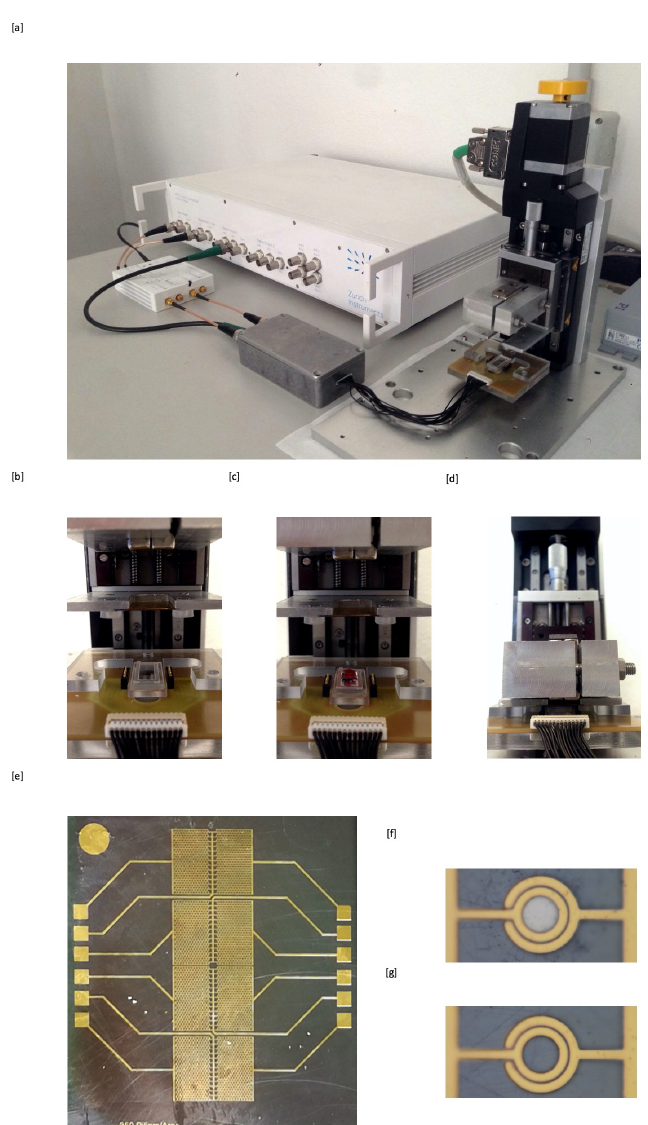
Figure 1. ( a ) Picture of the measurement set-up. A transimpedance amplifier (HF2TA) is used to convert the current flowing into the electrodes, upon application of a sinusoidal voltage with 100 mV amplitude at 1 MHz, in a voltage signal fed to a lock-in amplifier (HF2LI), both provided by Zurich Instrument. In this protoype, a first stepper motor (L40620SD00 from PhI) is used for the chip lowering, while a second stepper motor (M126 CG1 from PhI), mounted on the first, implements the magnet approach/disengagement. ( b ) Chip loaded on the holder mounted on the first stepper motor; ( c ) blood sample dispensed on the glass slide with a PDMS gasket; ( d ) chip pressed on the glass slide to define the fluidic chamber and realize the electric contacts on gold pads by spring contacts mounted on the same support of the glass slide; ( e ) chip layout; ( f ) zoom on a single measurement electrode on top of a Ni pillar; ( g ) zoom on a single reference electrode without Ni pillar